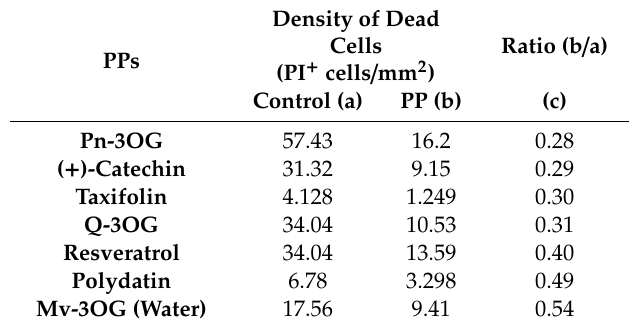
Table 1. Percentages of reduction of the density of dead cells in controls ( a ) and after incubation in PPs ( b ) containing